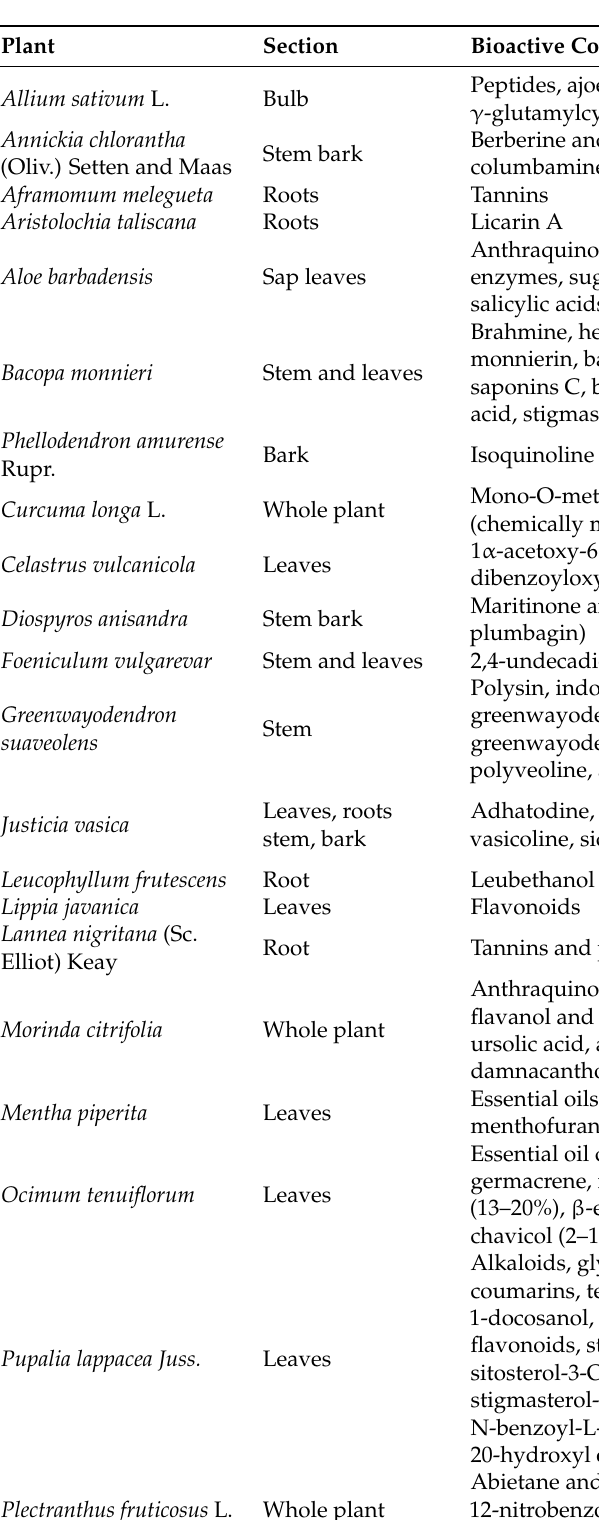
Table 4. Isolated bio-active compounds with anti-tubercular